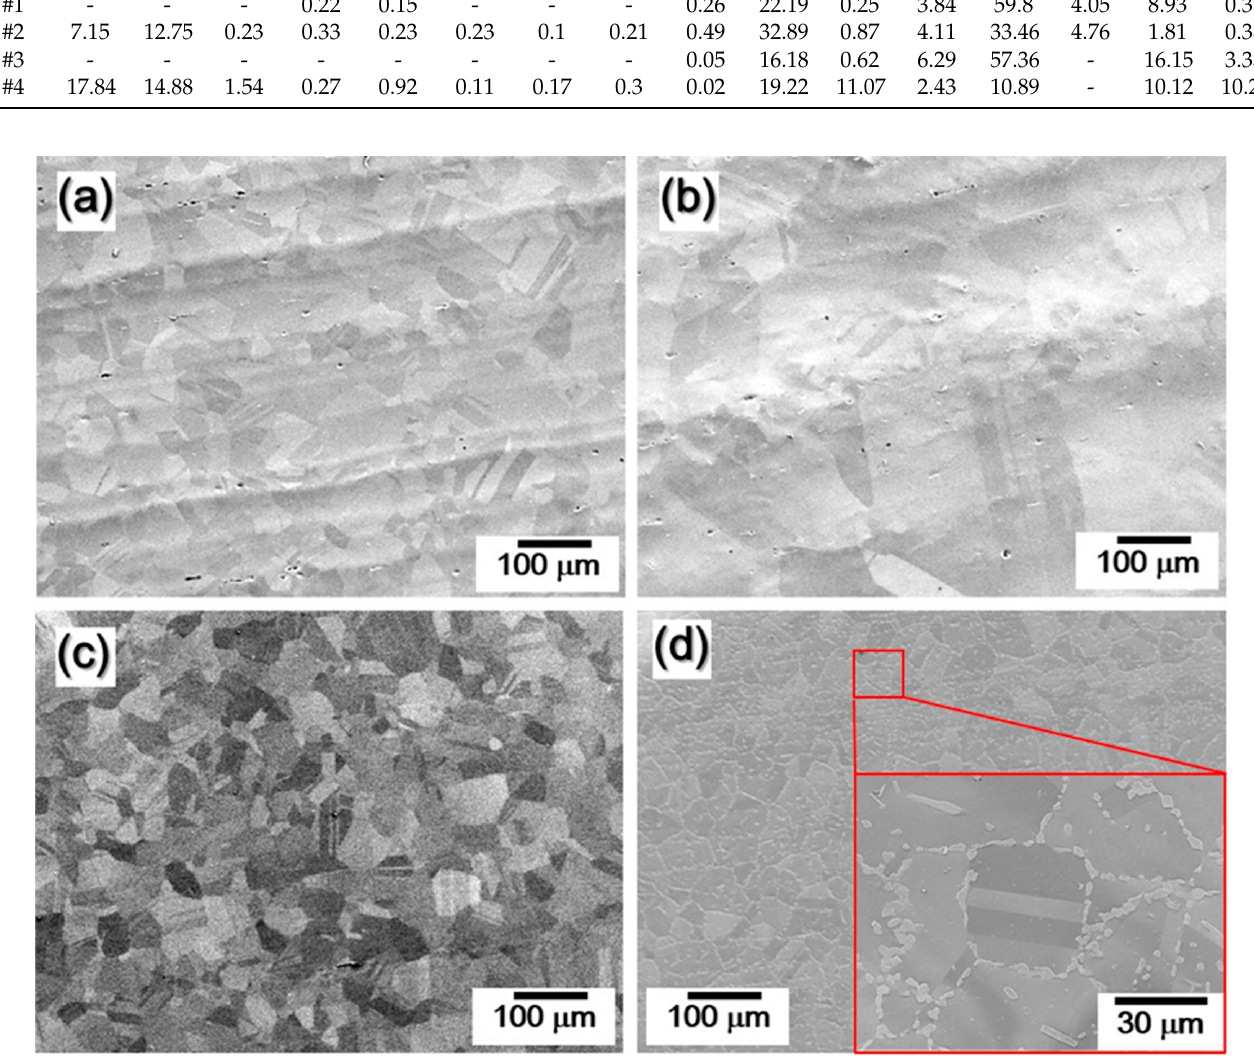
Figure 2. SEM characterization of the Ni-based alloys before and after heat treatment; specimens ( a ) #1, ( b ) #2, ( c ) #3 and ( d ) #4.